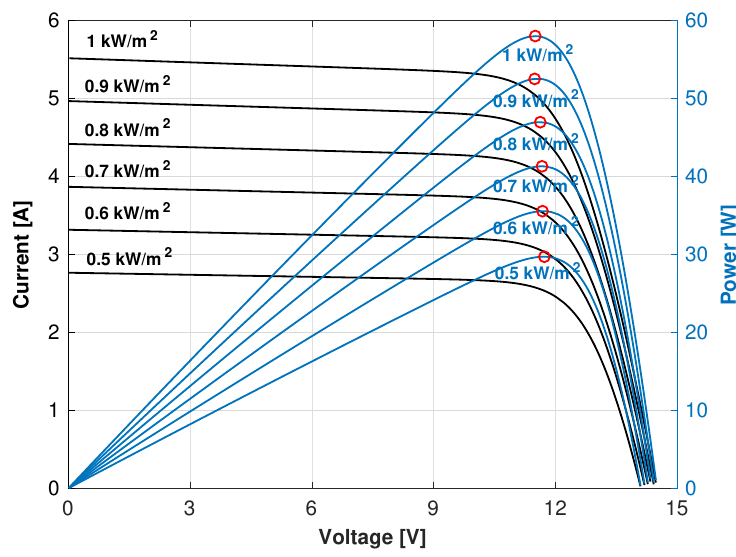
Figure 13. Current (black) and Power (blue) against Voltage curves for low power PV array simulations.